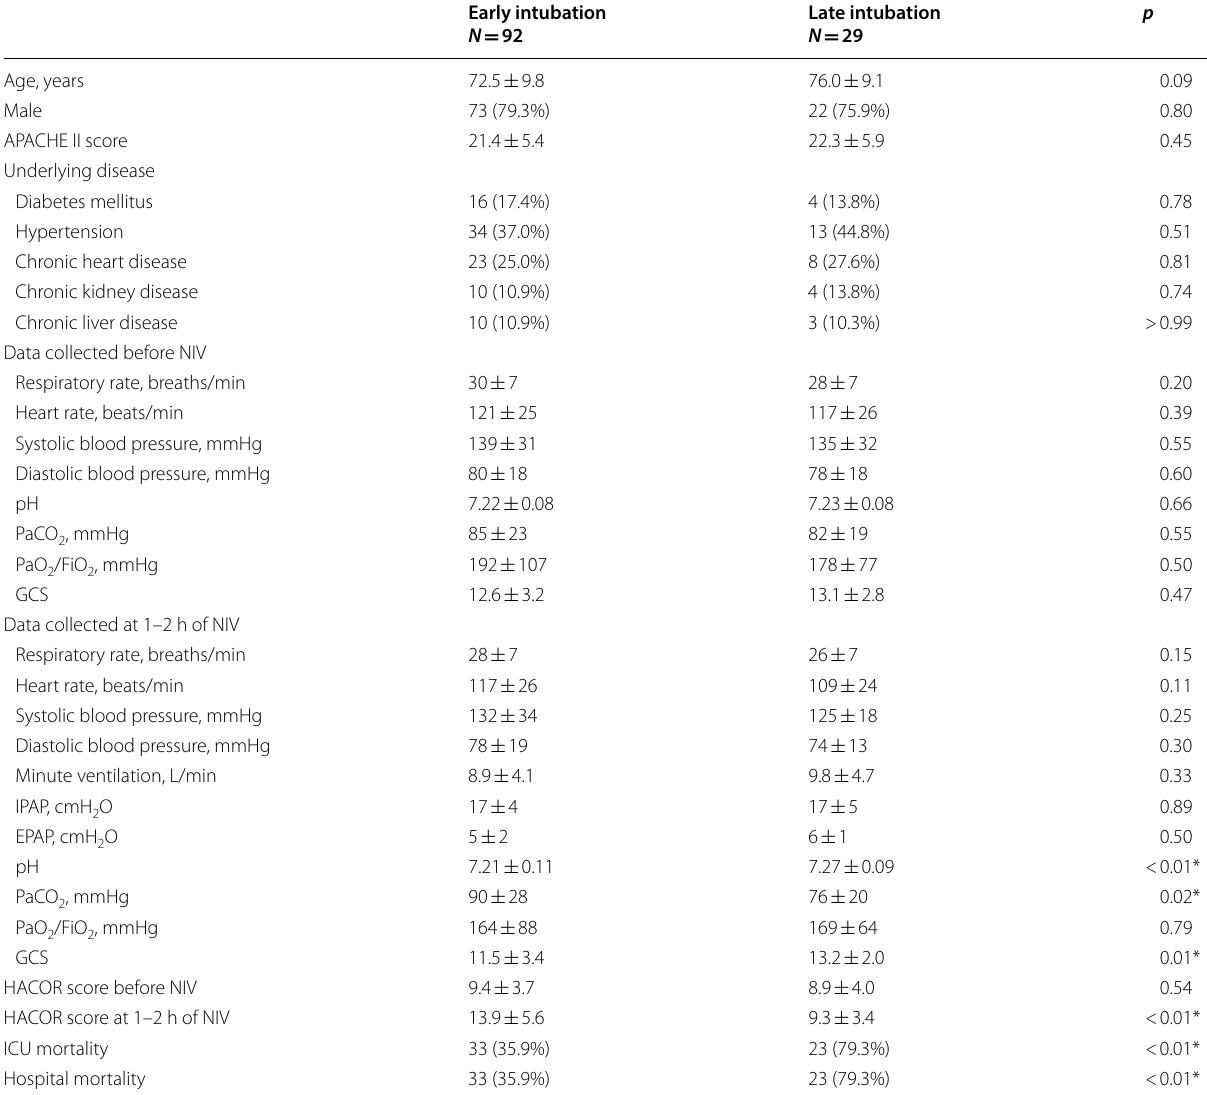
Table 5 Early versus late intubation in patients with HACOR score > 5 at 1–2 h of